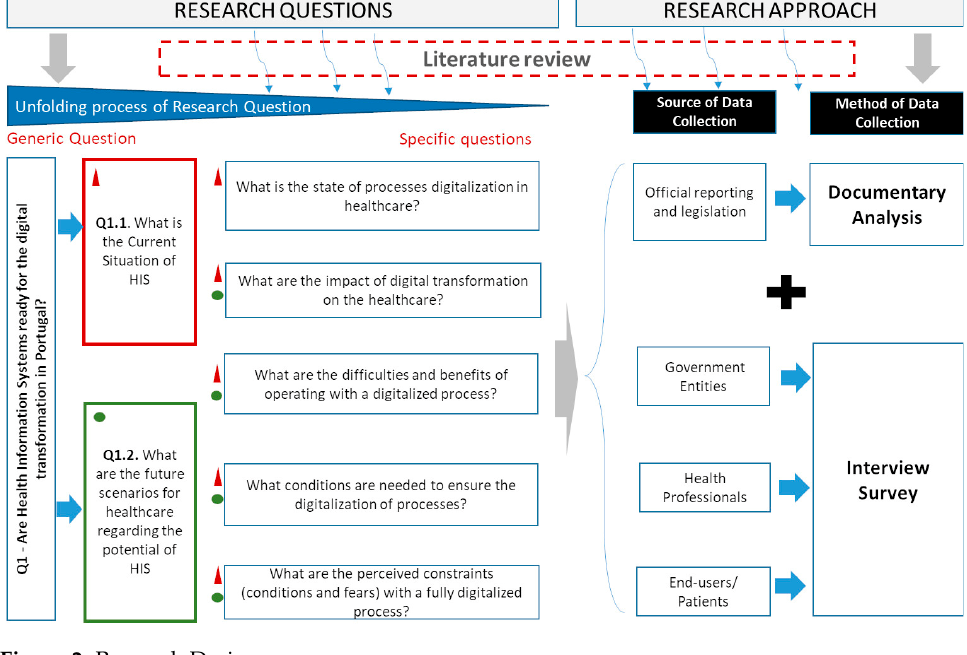
Figure 2. Research Design.